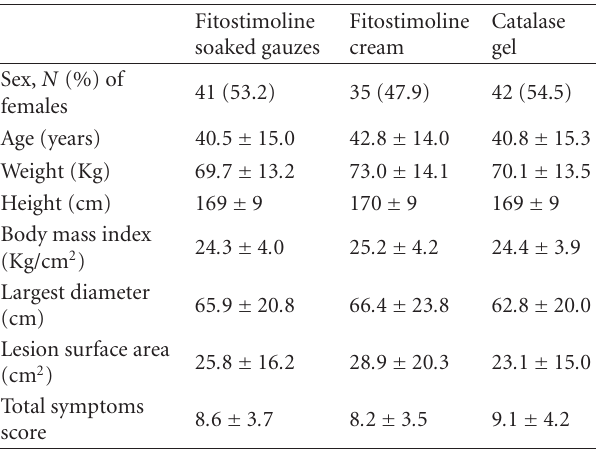
Table 1: Demographic and lesion baseline characteristics in the three groups (all patients enrolled). Entries are mean ± standard deviation, unless otherwise